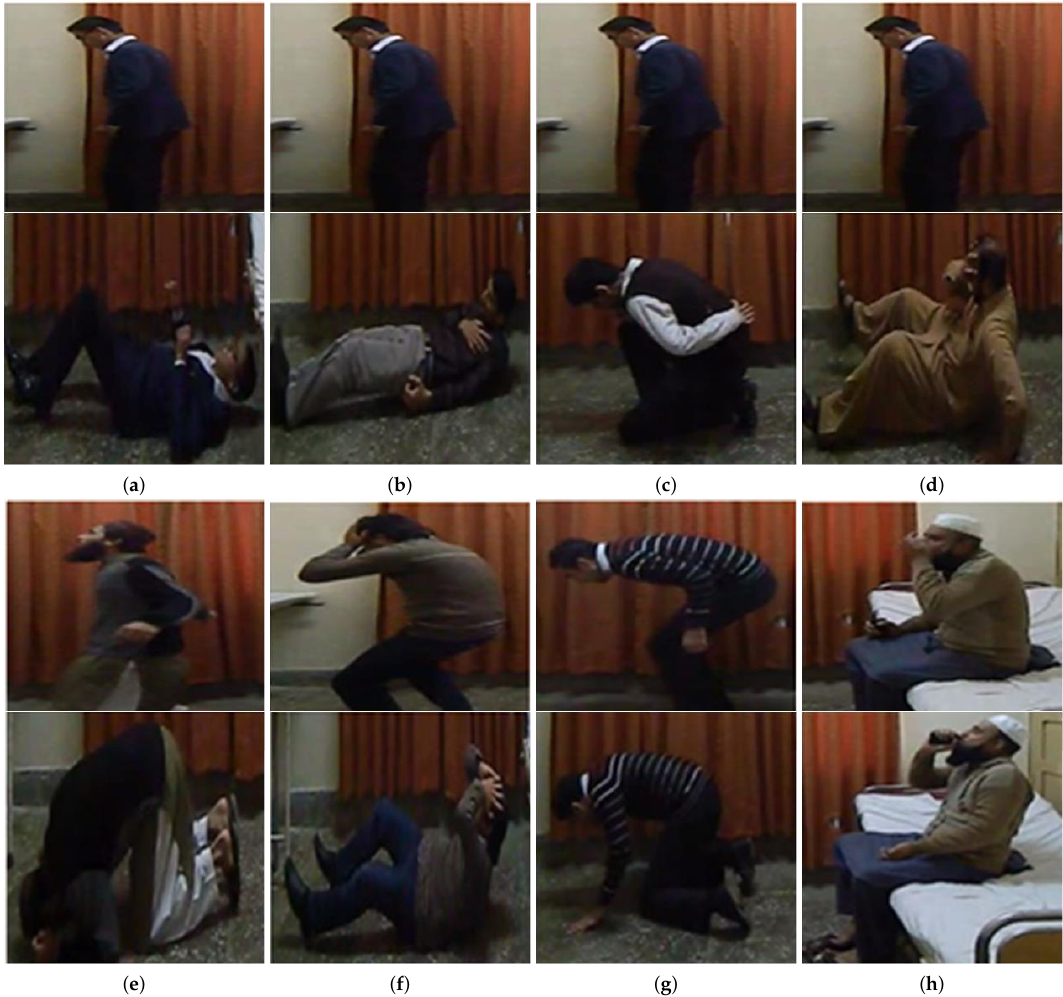
Figure 5. The two sets of multiple frames of human activities are performed: ( a ) backward fall ( b ) chest pain ( c ) coughing ( d ) faint ( e )l forward fall ( f ) headache ( g ) vomit and ( h ) taking